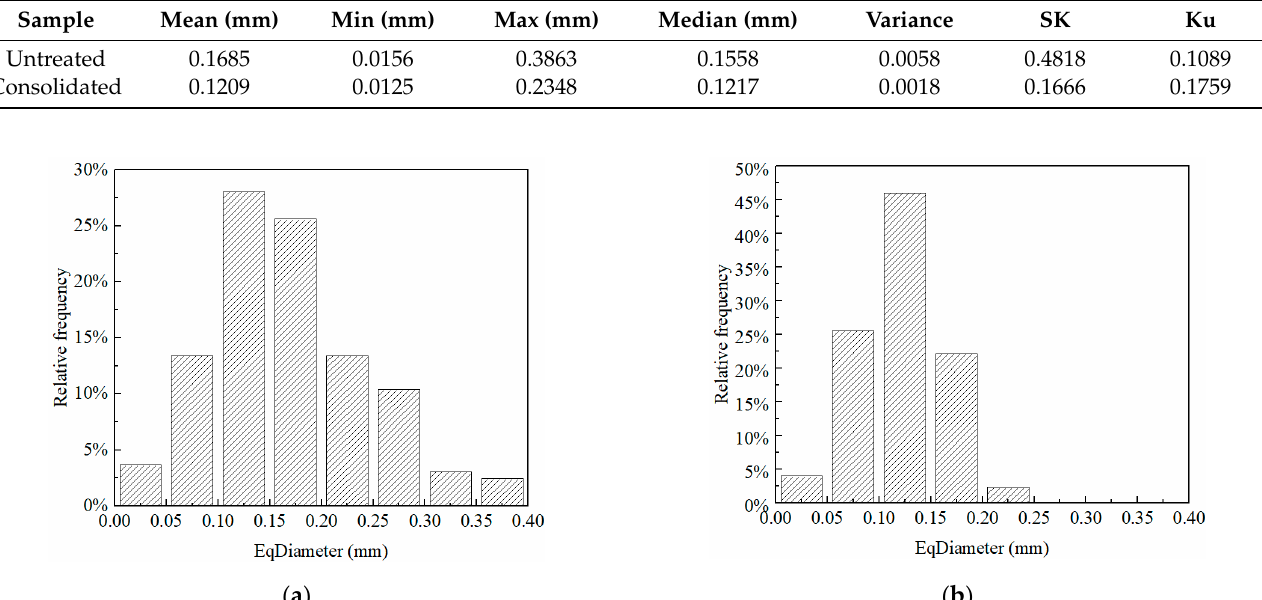
Figure 5. The equivalent diameter distribution of pores: ( a ) untreated sample; ( b ) consolidated sample.